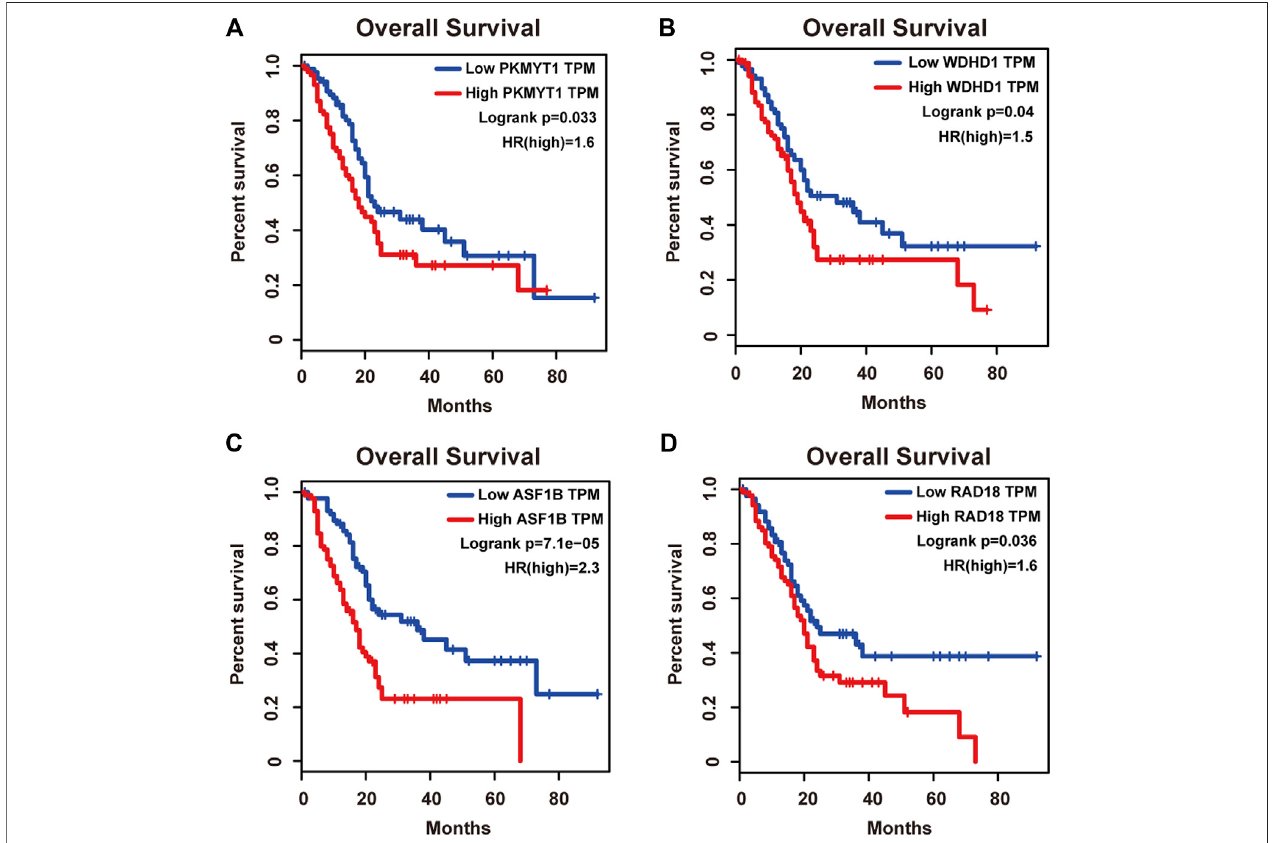
FIGURE4| OverallsurvivalanalysisofthefourhubgenesinpancreaticadenocarcinomabasedontheKaplan-Meierplotter. (A) PKMYT1. (B) WDHD1. (C) ASF1B. (D) RAD18. The high expressions of these four genes were associated with high risk.